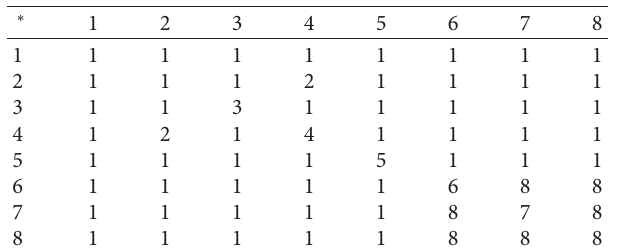
Table 4: Table of Example